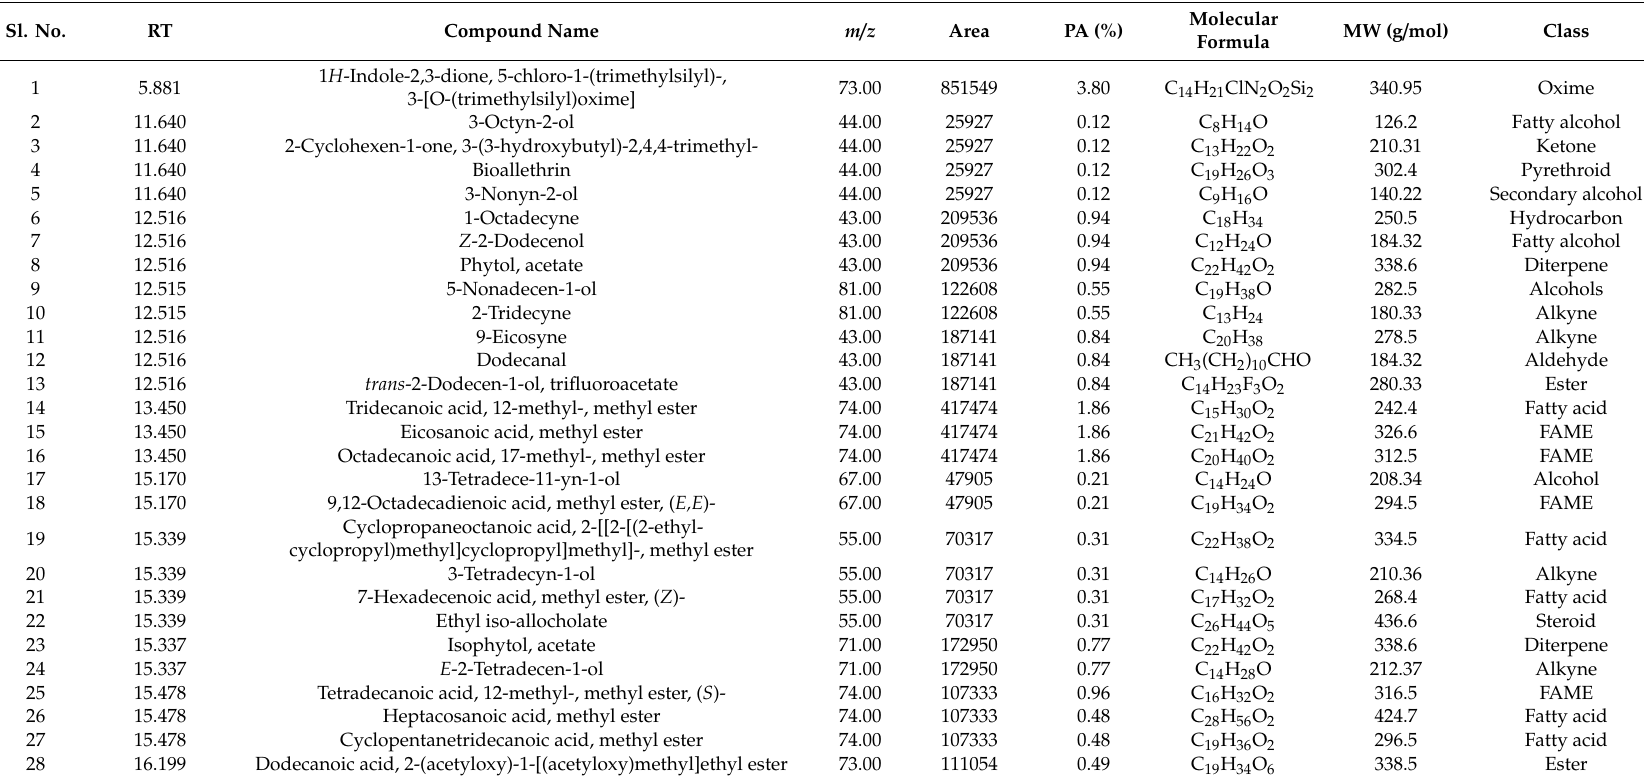
Table 1. Quantitative compounds identified from methanol extract of C. pectinata by GC-MS analysis. Sl.